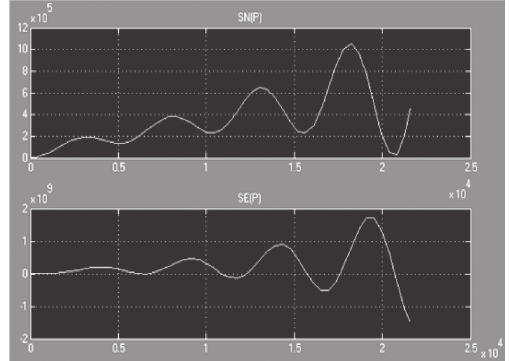
Fig. 11. Graphs of errors on both channels traversed the path of inertial systems when there is cross-connection between the channels due to transfer coefficients knpv = 0.001, knpv1F = 0.001, knpv2F = 0.001, and knpv V2 =